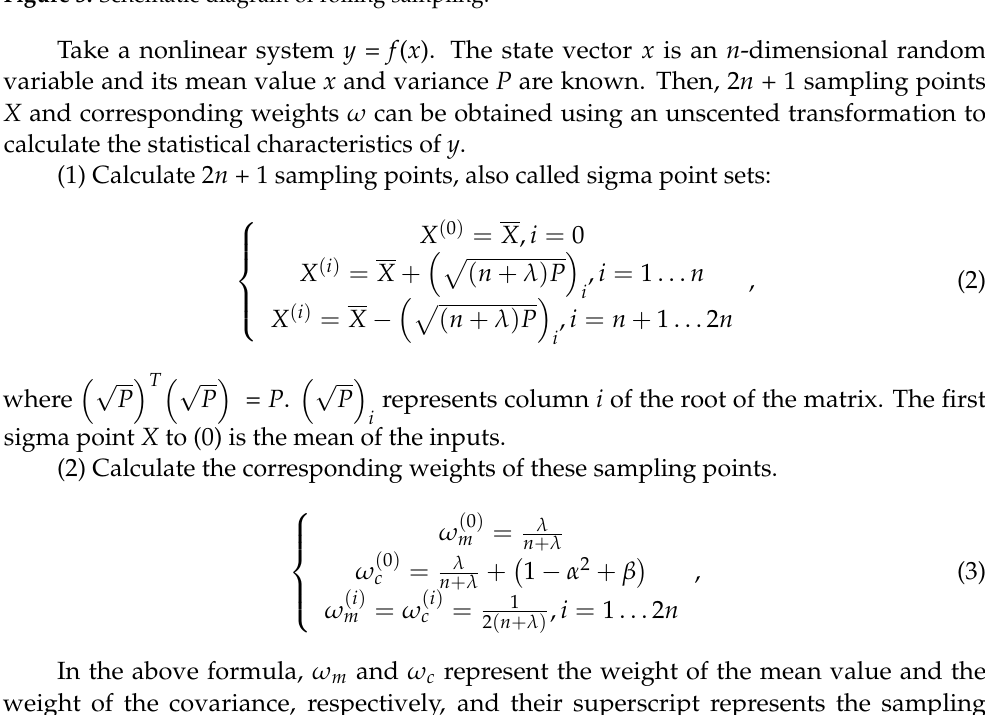
Figure 3. Schematic diagram of rolling sampling.